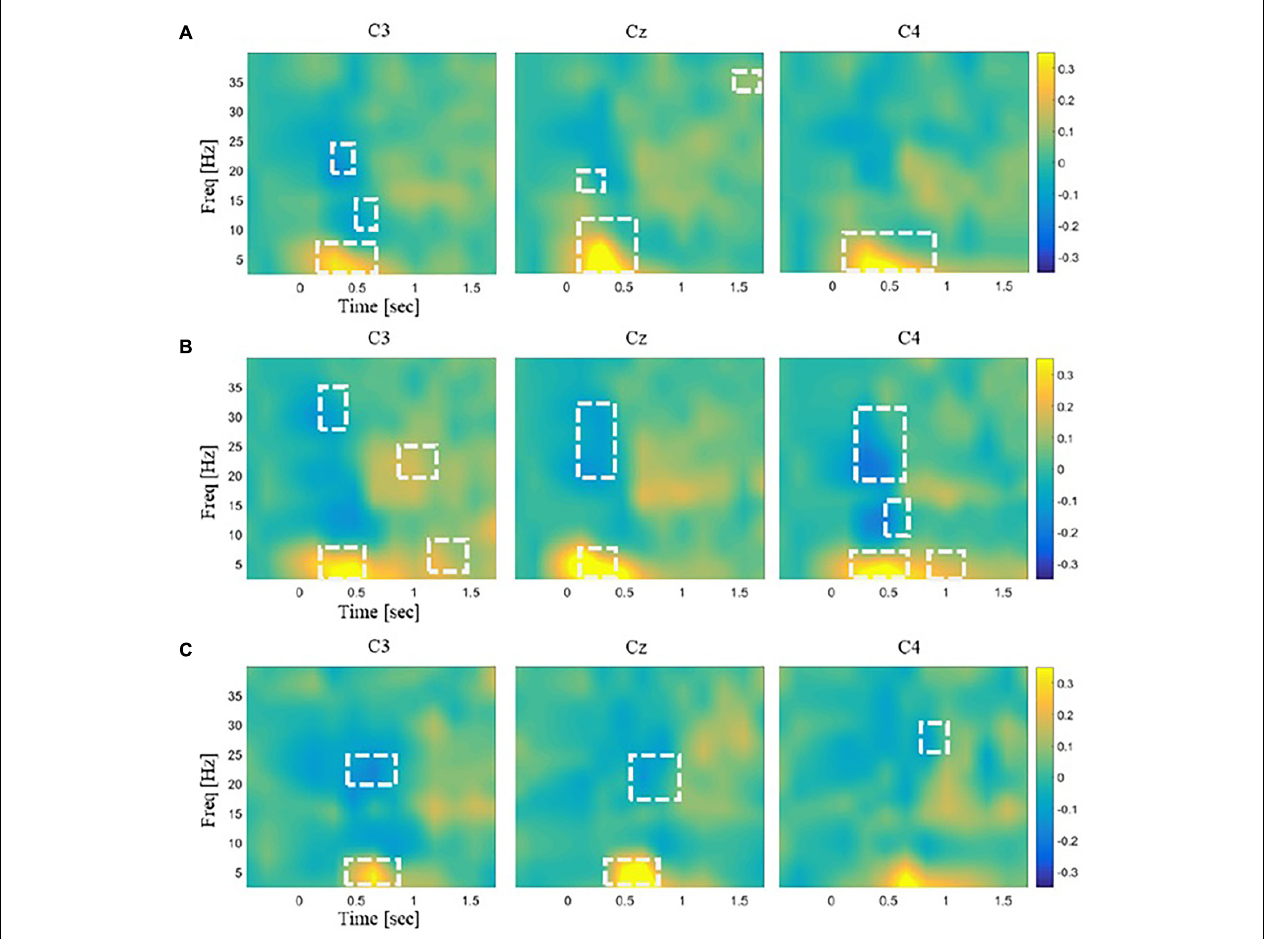
FIGURE 3 | Illustrations of the time–frequency EEG responses to stimulations. The spectral power for each frequency band was normalized to the mean of the baseline period (–2,000 ms). The normalized power data were averaged across the trials for each channel and each stimulus. Time–frequency regions showing significant changes in power from baseline were marked by white dashed lines ( p < 0.01). The color bar unit indicates the power ratio. The time–frequency EEG patterns for three somatosensory channels C3, Cz, and C4 are shown in response to panel (A) laser plasma stimulation, (B) mechanical stimulation, and (C) sham